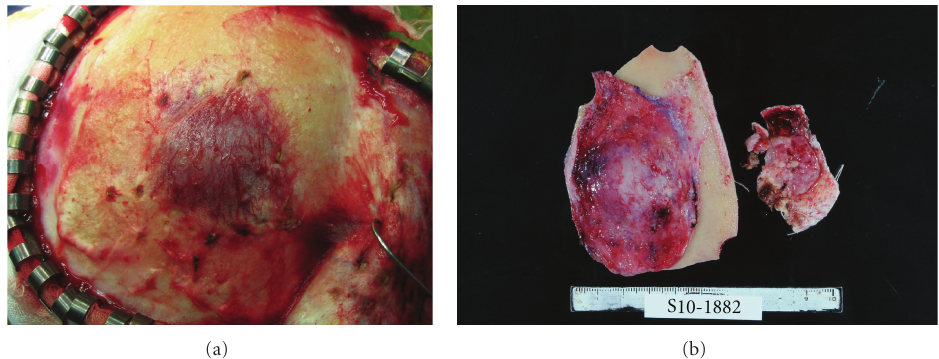
Figure 2: Intraoperative photographs of the tumor. (a) Complete exposure of the tumor covered by the periosteum. (b) Resected tumor with